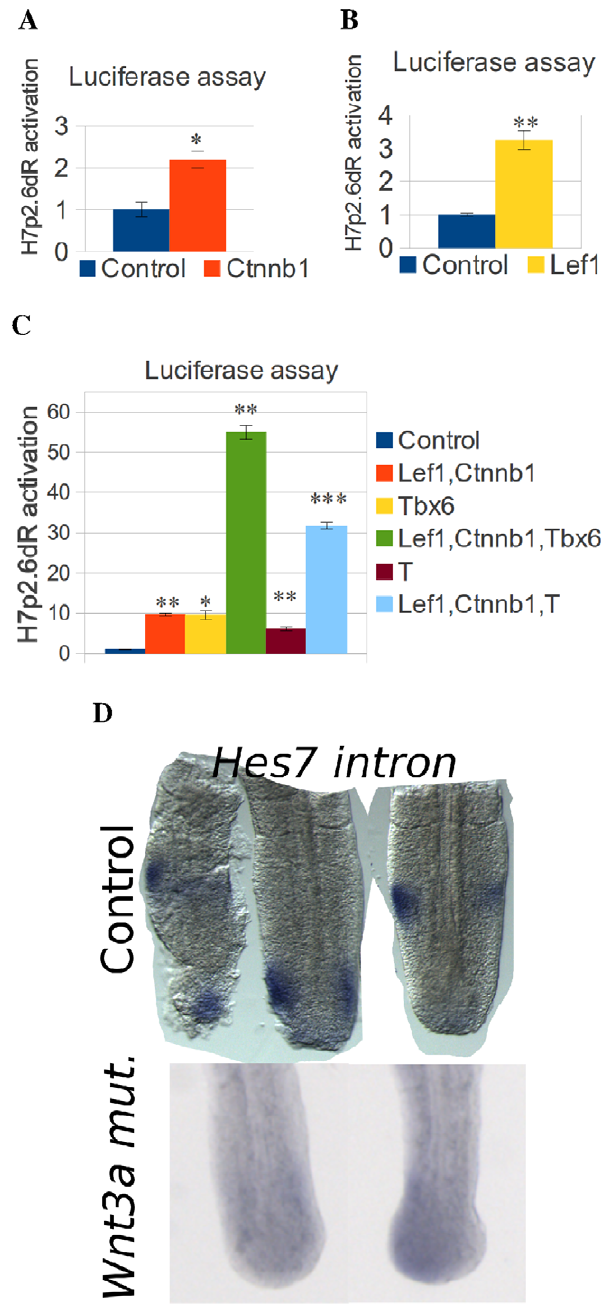
Figure 3. Activation of Hes7 expression by the Wnt pathway. (A,B,C) Hes7 promoter luciferase reporter assay of the H7p2.6dR promoter reporter after co-transfection of constitutively active Ctnnb1 , Lef1 , T and Tbx6 expression plasmids. (A,B) The H7p2.6dR promoter reporter is activated by constitutively active Ctnnb1 and Lef1 expression plasmids. (C) The Ctnnb1 and Lef1 mediated activation of the H7p2.6dR promoter reporter is synergistically enhanced by co-transfection of both T and Tbx6 expression plasmids. (D) Hes7 intronic expression in Wnt3a hypomorph E10.5 mutant embryos. In the mutant, Hes7 intronic expression (n=7) is downregulated compared to the control (n=9).